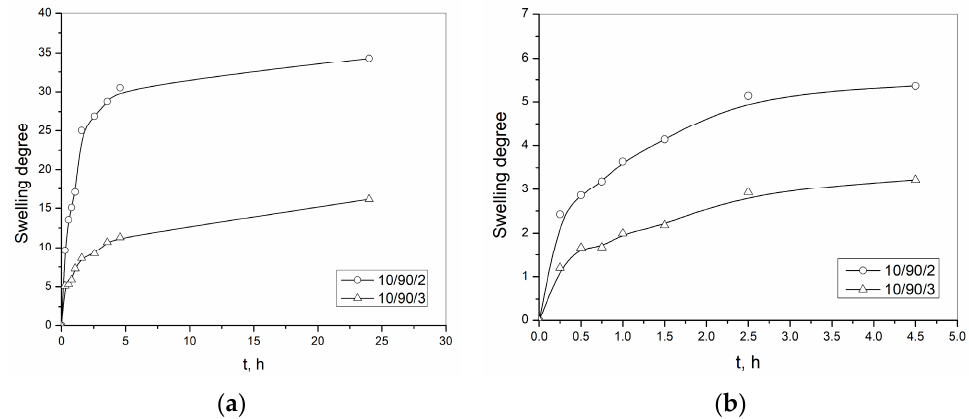
7, and it can be seen that degree of swelling decreases when temperature increases. There